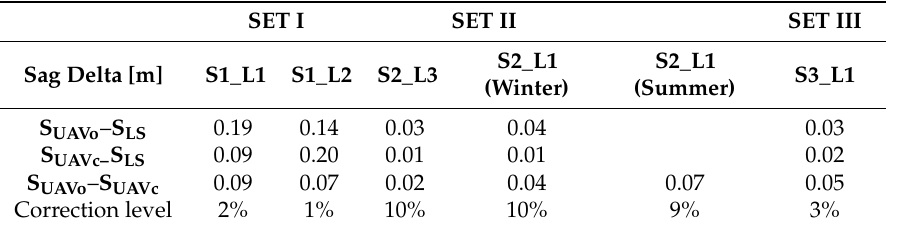
Table 6. Comparison of line sag before and after correction for UAV imagery and laser scanning. SET I